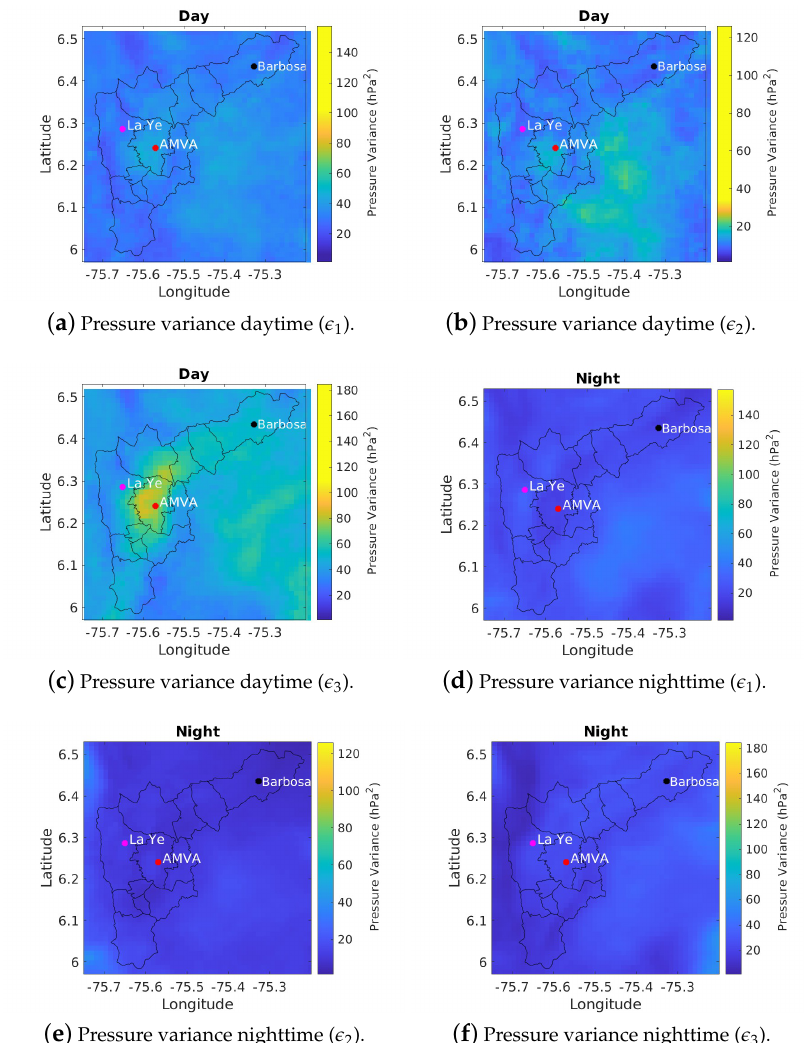
Figure 6. Average pressure variance for each kind of perturbation by using 100 ensembles. ( a ) Vari- ance in the daytime for (cid:101) 1 . ( b ) Variance in the daytime for (cid:101) 2 . ( c ) Variance in the daytime for (cid:101) 3 . ( d ) Variance in the nighttime for (cid:101) 1 . ( e ) Variance in the nighttime for (cid:101) 2 . ( f ) Variance in the nighttime for (cid:101) 3 .